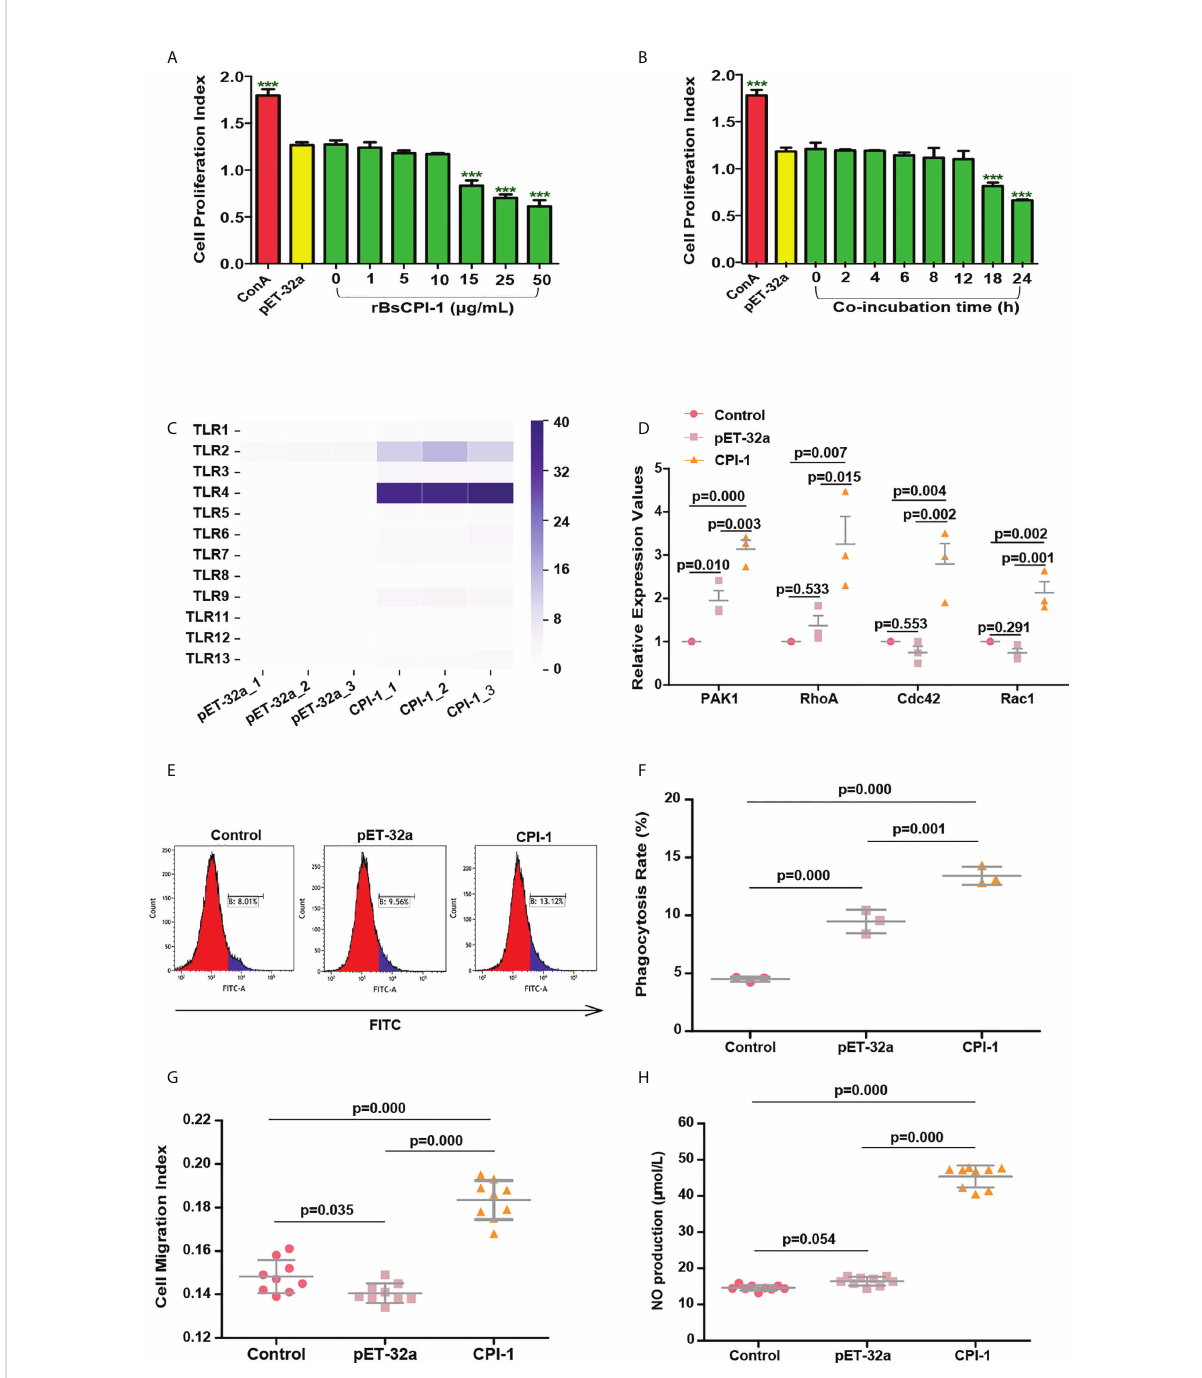
FIGURE 2 rBsCPI-1 activates the TLR2/4-small Rho GTPases-PAK1 pathway and affects the phagocytosis and migration of MDMs. (A, B) rBsCPI-1 effects the proliferation of MDMs. Proliferation was measured by CCK-8 assay after MDMs stimulation with ConA along or combined with PBS, pET-32a and rBsCPI-1. The OD 450 values were considered the cell proliferation index. *** P ≤ 0.001 for other groups vs. the 0 m g/mL group or for other groups vs. the 0 h group. (C) rBsCPI-1 increased the relative expression of TLR2 and TLR4 on MDMs. (D) rBsCPI-1 affected the relative expression of the RhoA/Rac1/Cdc42-PAK1 pathway in MDMs. (E) Phagocytosis of MDMs was determined by analysis of the phagocytosis of FITC-dextran using FCM. (F) The percentage of FITC+ cells presented is representative of three independent experiments. (G) Random migration was determined by using a Millicell ® insert with 8.0 µm pores, and the OD 570 values were considered the migration index. (H) The NO concentration was measured and converted to micromoles per liter (µmol/L) using a standard curve. The data are shown as the mean ± SD of 3 repetitions per